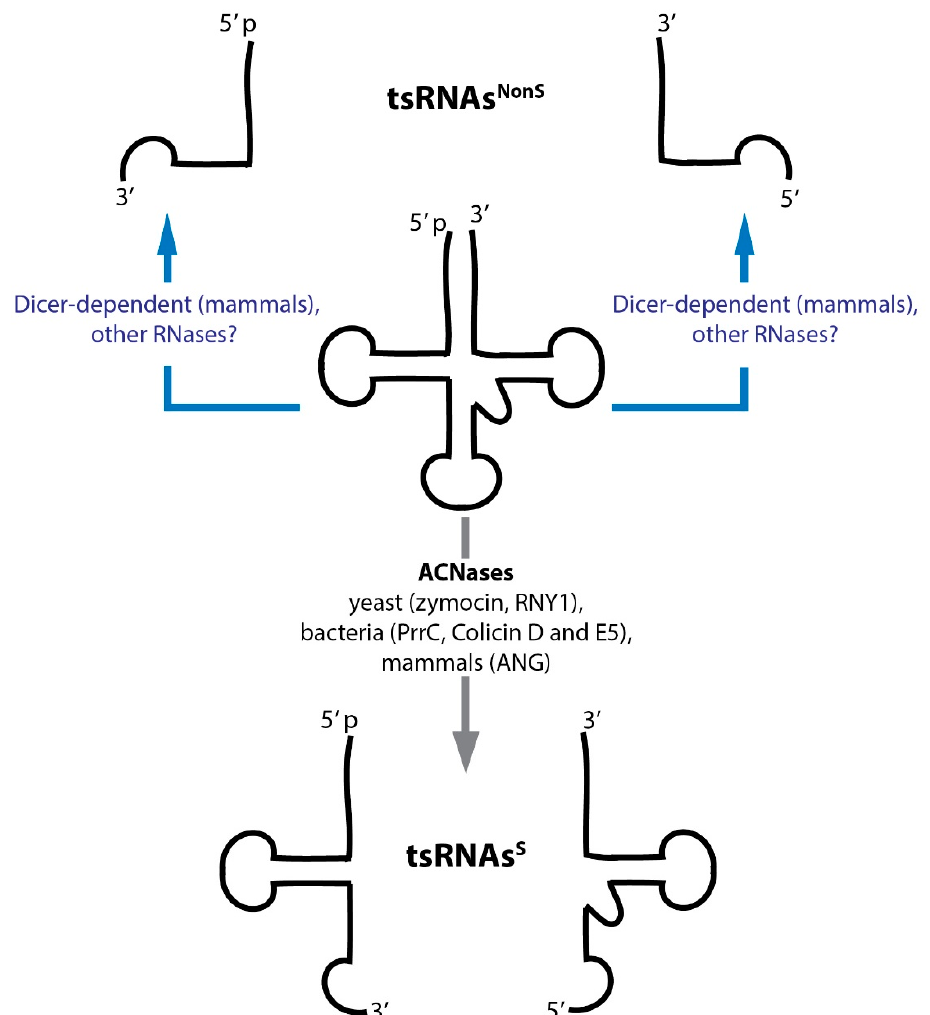
Figure 1. Transfer RNAs ( tRNAs) give rise to various tRNA-derived small RNAs (tsRNAs). tRNAs are preferentially cleaved in open loop structures. Dicer enzymes, as well as unknown RNases cleave tRNAs in the D- or T-loops, producing short tsRNAs in a mostly stress-independent fashion (tsRNAs NonS, , see text). The activity of various anticodon ribonucleases (ACNases) targeting the anticodon loops produces longer tsRNAs, often during stress conditions (tsRNAs S , see text).